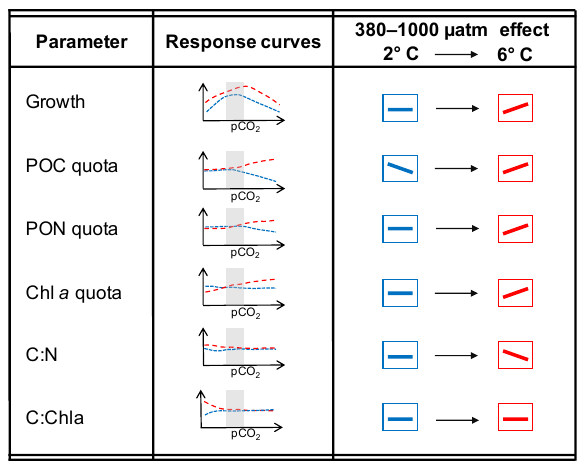
Figure 3. Schematic illustration of results for both temperatures over the entire range of p CO 2 levels as well as focusing on the re- sponses between 380 and 1000µatm (as the representation for com- monly used OA treatments) and their modulation by